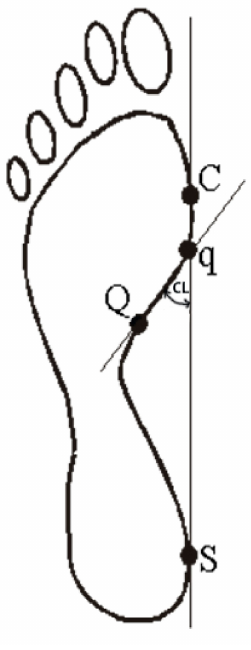
Figure 2. Procedure for determining Clarke’s angle.